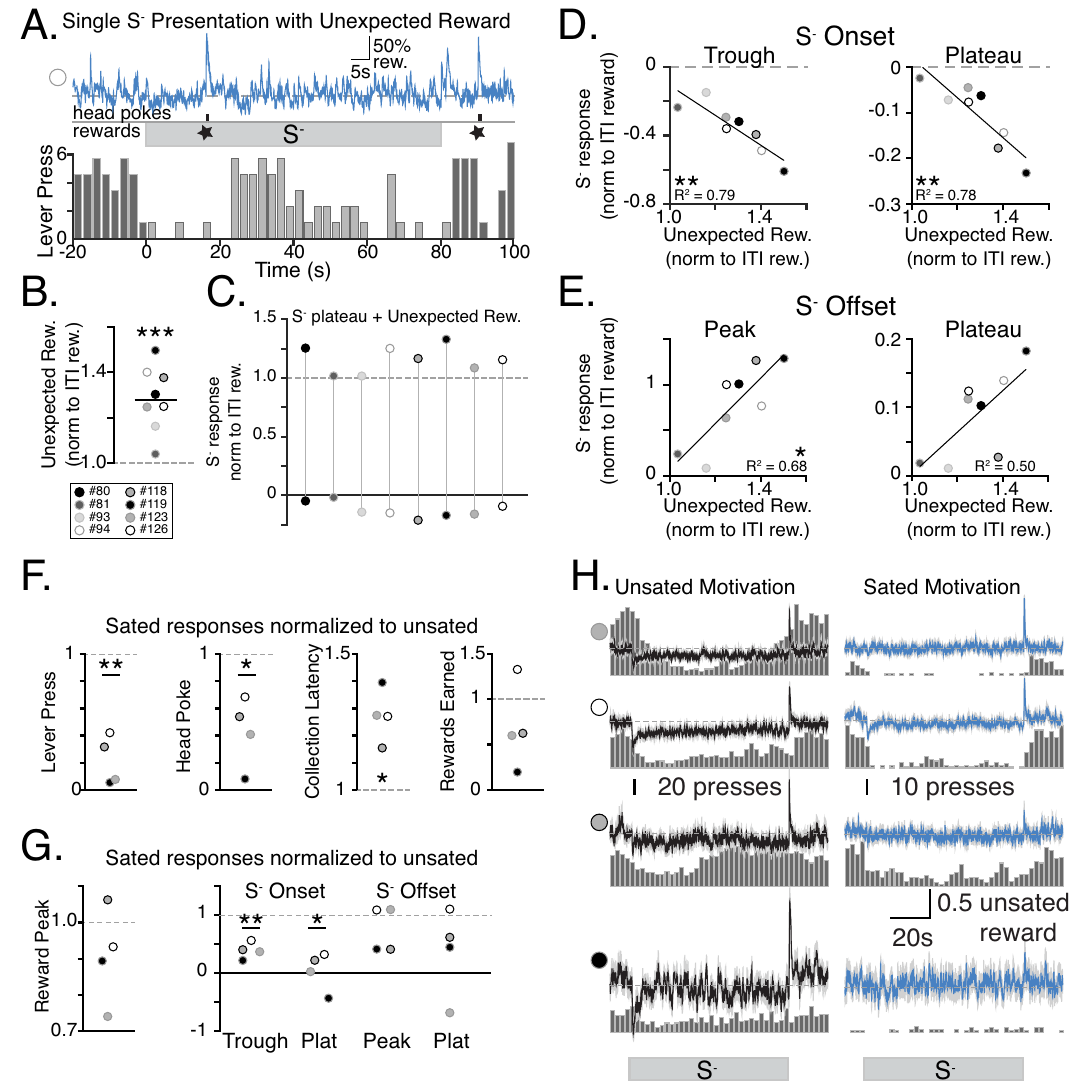
Fig. 6 Dopamine dynamics predict response to unexpected reward and are altered by motivational state. A Single S − presentation with unexpected reward to lever press during tone. DA response on top and behavior below. The dLight trace is scaled proportional to 50%rew(ard), 50% of the average peak response to reward on that day of recording. B Average peaks of unexpected rewards normalized to rewards earned during ITI. One-sample t test compared to 1.0: t (7) = 5.499, p = 0.0009. C The DA response to surprising rewards during S − (relative to ITI rewards) is depicted for each subject by a line that extends from the S − plateau (below 0) to its peak height relative to ITI baseline levels. D , E Strength of encoding of S − onset ( D ) and offset ( E ) compared with amplitude of unexpected rewards. Linear Regression: Extra Sum of Squares F-test for unexpected reward and S − onset trough: F (1, 6) = 22.06, P = 0.0033, S − onset plateau: F (1, 6) = 21.29, p = 0.0036, S − offset peak: f (1, 6) = 12.58, p = 0.0121, S − offset plateau: f (1, 6) = 5.922, p = 0.0509. F Behavior and reward responses following reward satiety normalized to responses with satiety intact, One-sample t test compared to 1.0, Lever presses: t (3) = 8.659, p = 0.0032, Head pokes in reward port: t (3) = 4.424, p = 0.0214, Collection latency: t (3) = 5.559, p = 0.0115, Rewards earned: t (3) = 1.318, p = 0.2792. G DA responses to Reward and S − following satiety. One-sample t test compared to 1.0, Reward Peak: t (3) = 1.39, P = 0.2588, S − onset trough: t (3) = 8.61, P = 0.0033, S − onset plateau: t (3) = 5.757, p = 0.0104, S − offset peak: t (3) = 1.26, p = 0.2999, S − offset plateau: t (3) 1.657, p = 0.1961. H Average traces of DA in response to S − presentation with unsated (left) and sated (right) motivation overlaid on histogram of lever presses, dLight traces are scaled proportional to 0.5 rew(ard), where 1 reward is the average peak response to reward for each day of recording. Note difference in scales for lever presses. B , H gray shading is s.e.m. B – E N = 8 animals. F – H Sated responses normalized to unsated responses. N